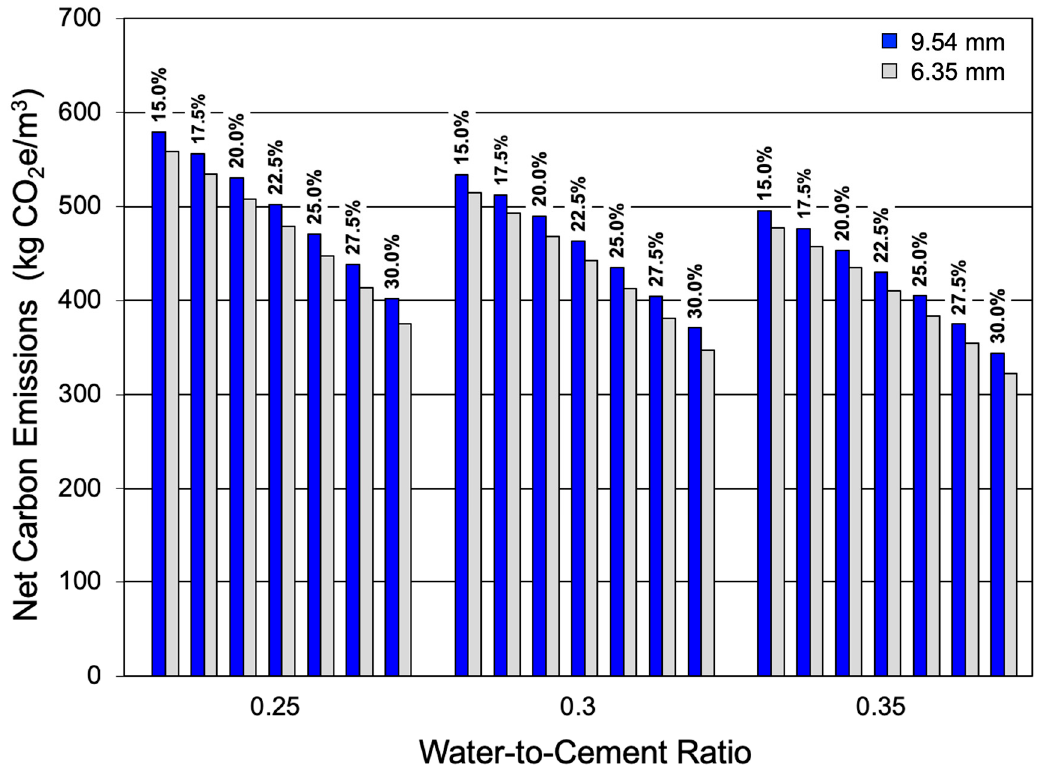
Figure 6. Net CO 2 e emissions of 1 m 3 of pervious concrete. Design porosity of each mixture is indicated above its respective column. Aggregate size is differentiated by color.